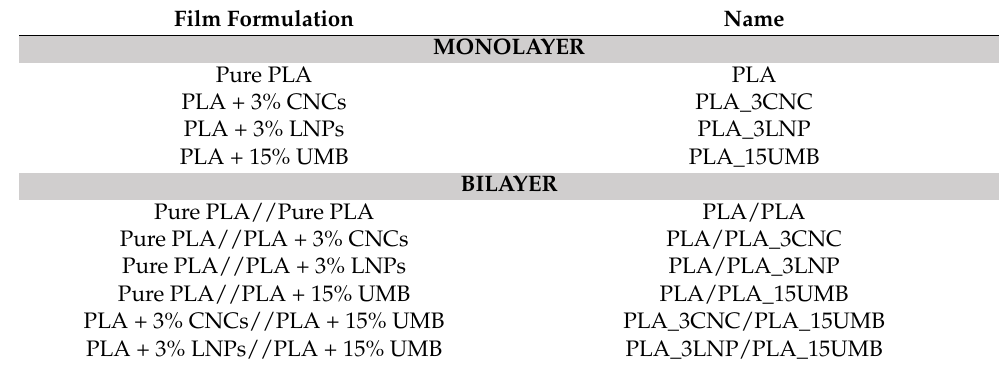
Table 1. Name and description of material